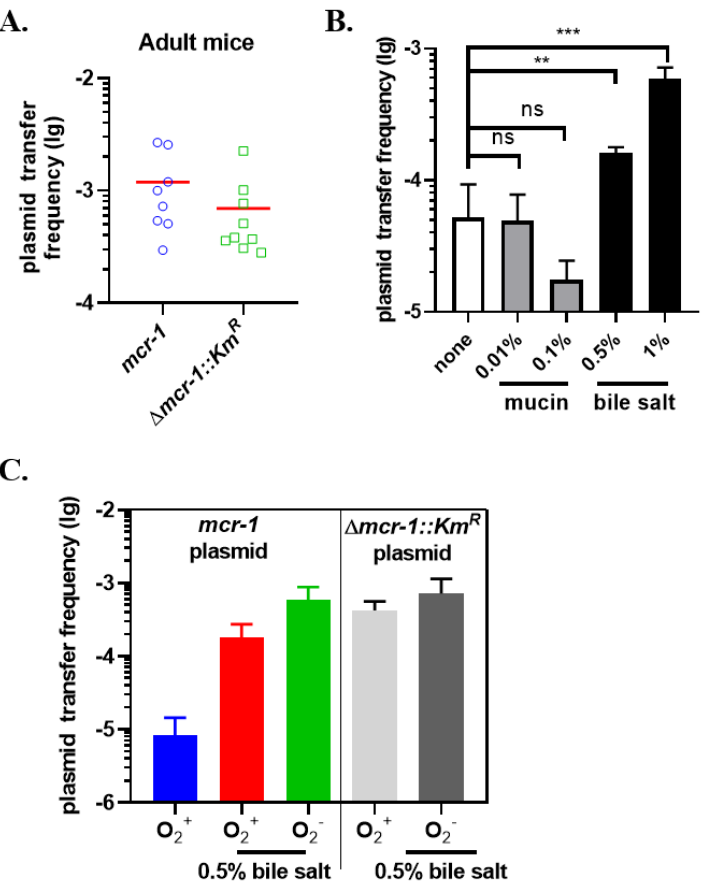
Figure 5. Influence of oxygen and bile salt on plasmid transfer. ( A ) Plasmid transfer in vivo. Five-week-old CD-1 mice were pretreated with streptomycin. Approximately 10 8 cells of different donor strains, namely, K. pneumoniae A2312NM harboring mcr-1 plasmid, A2312NM containing the ∆ mcr-1::Km R plasmid, were mixed with recipient strain K. pneumoniae MP13 separately and immediately administered to each mouse intragastrical. Fecal samples were collected after 3 days, and the transfer frequency was calculated. ( B ) The effect of mucin and bile salt on the transfer of mcr-1 plasmid. Conjugation was performed with or without additional mucin or bile salt. ( C ) Conjugation was performed with or without bile salt under different oxygen concentrations. Data are the mean and SD of three and more independent experiments. The significance was determined using t -test; ns, no significance; ** p < 0.01, *** p <